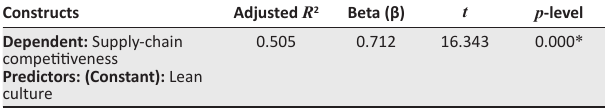
TABLE 5: Regression analysis of lean culture and supply-chain competitiveness. Constructs